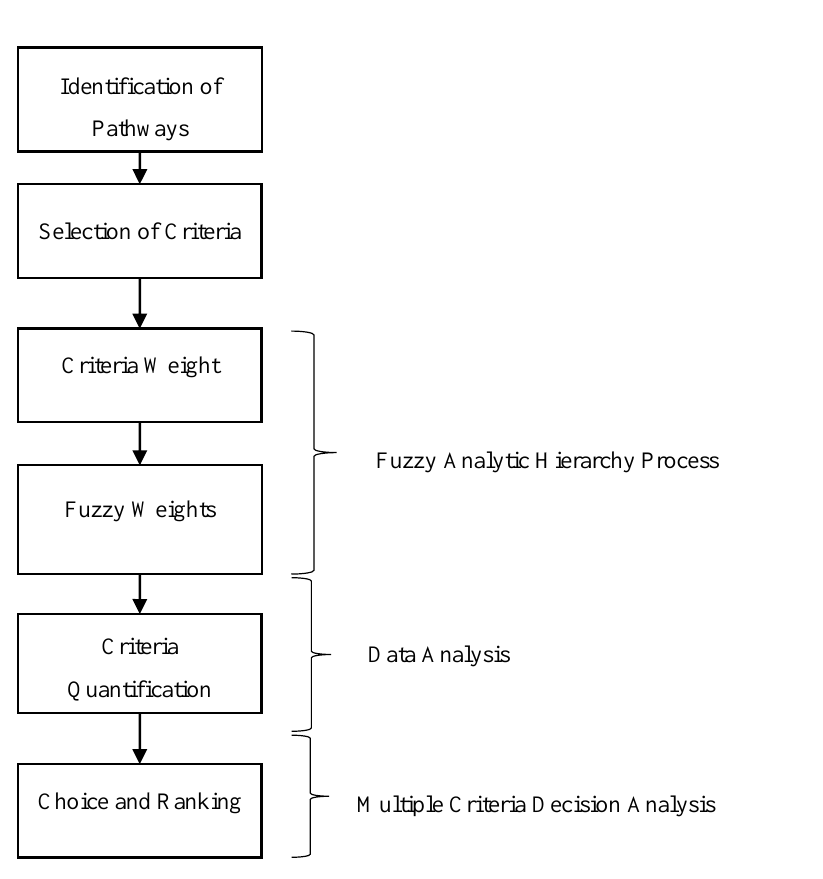
Figure 2. Application of Fuzzy Analytic Hierarchy Process for Selection of power-to-gas Pathways.